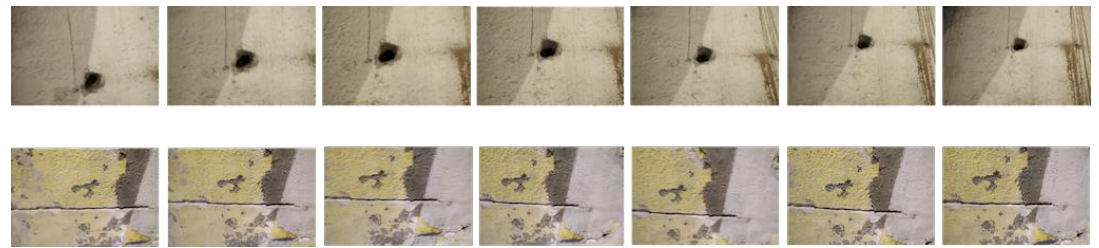
Figure 13. Sample of the dataset of surface imperfections used for the evaluation. The figure presents part of two frame sequences of the video stream take by the camera.